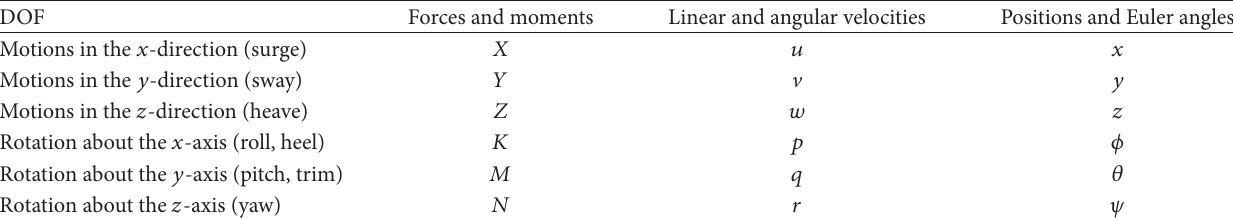
Table 1: The notation of math model according to